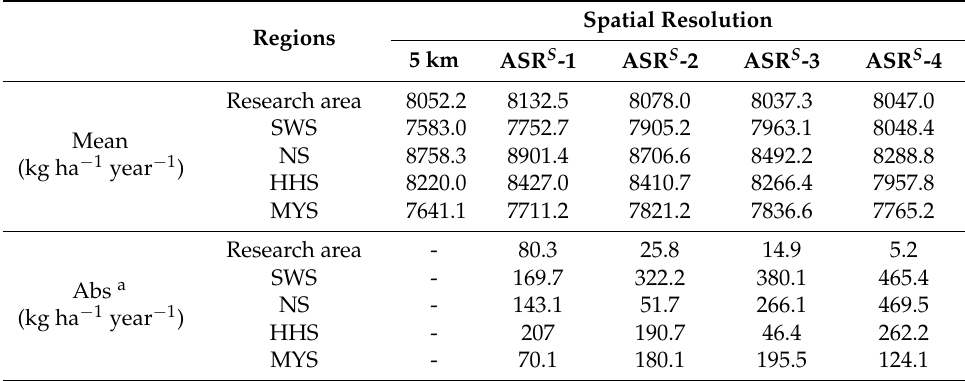
Table 2. Absolute difference between the average simulation results for the grids of different appropriate spatial resolutions and the average simulation results for the grid with a resolution of 5 km.